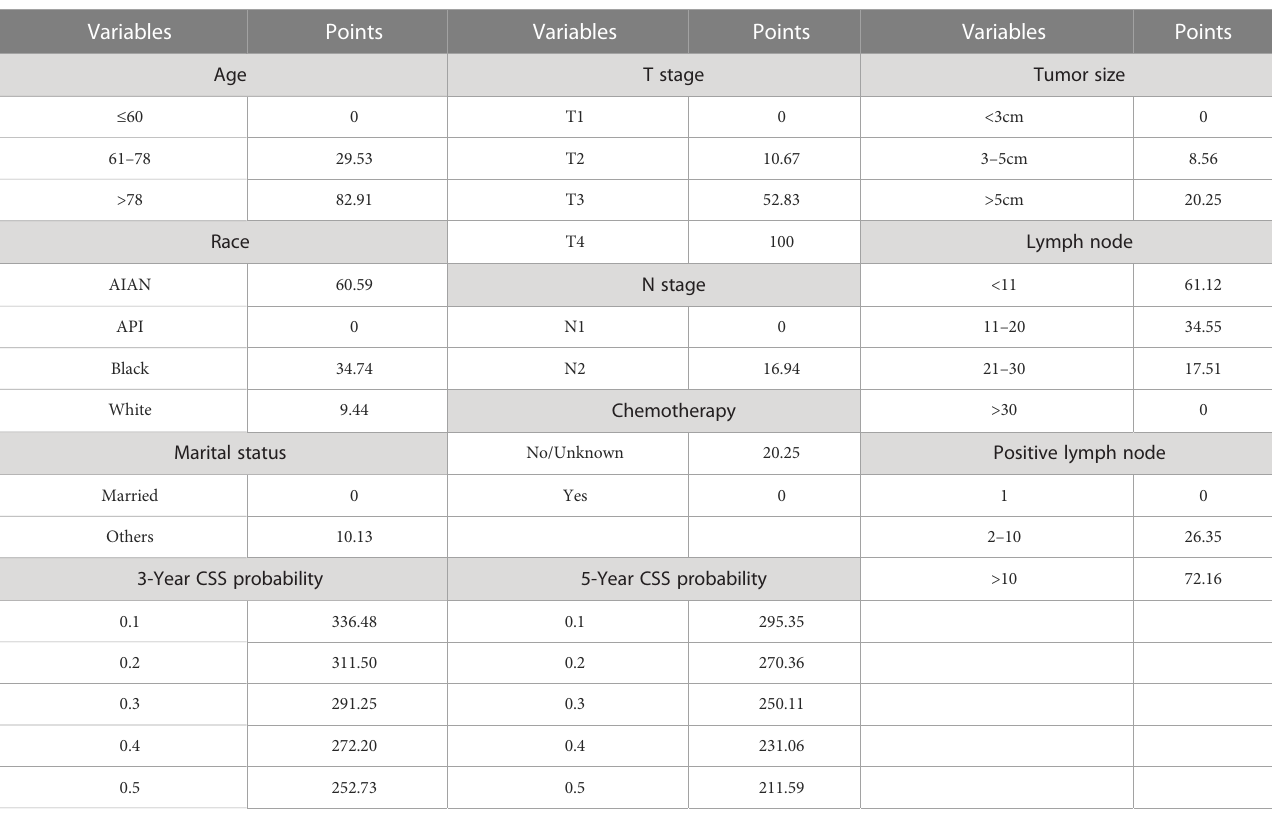
TABLE 3 Nomogram scoring